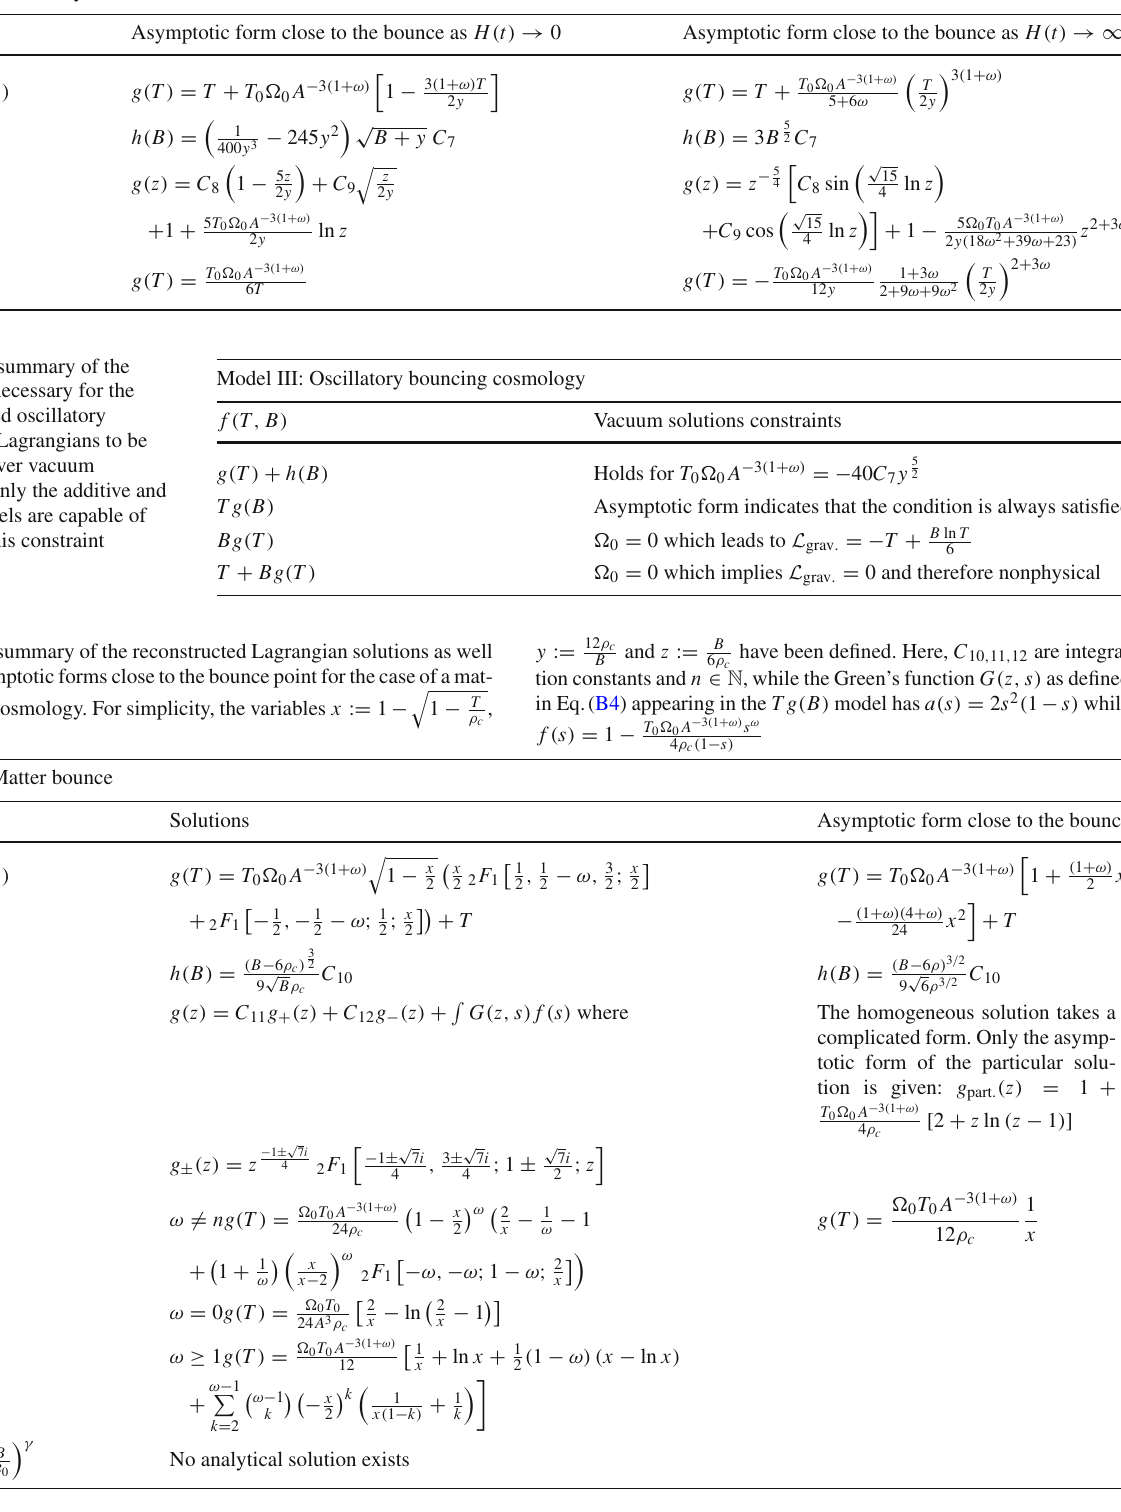
distinct bouncing behaviours, the Big Bang/Crunch singularity and the cosmological turnaround, the respective asymptotic forms close to each bounce are obtained. Here, z := 2